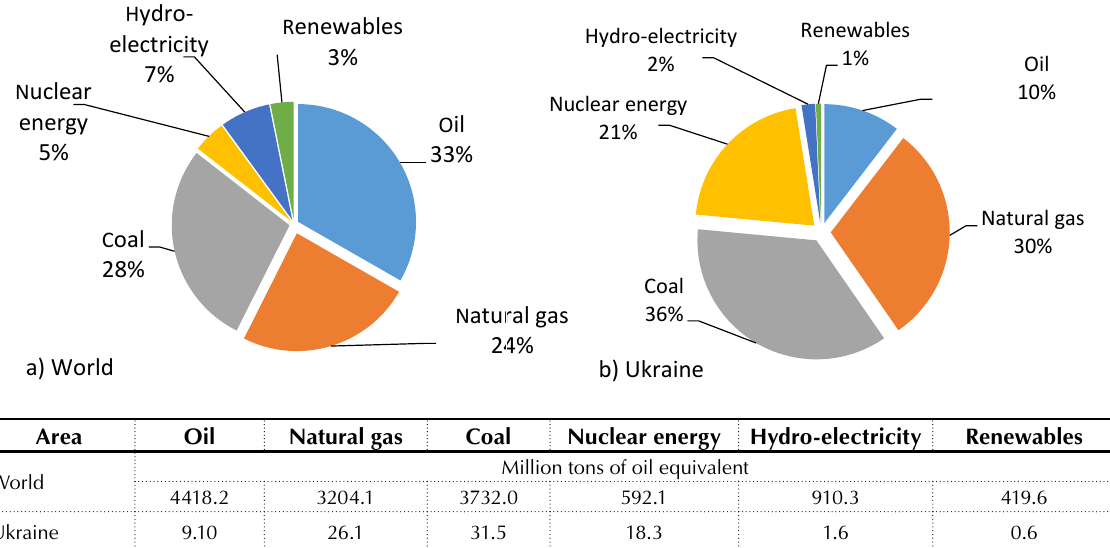
Figure 1. Structure of world (a) and Ukraine (b) energy consumption by type, 2016